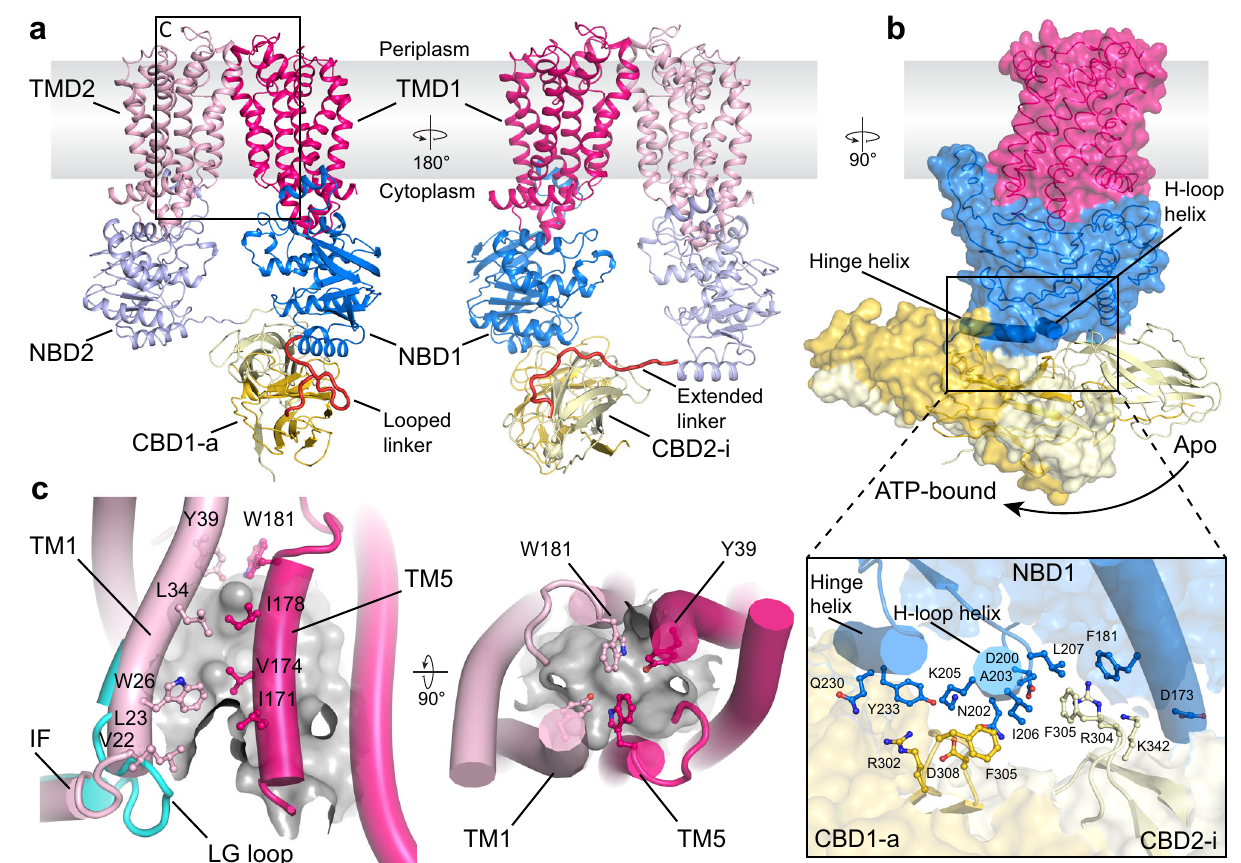
Fig. 3 | Cryo-EM structure of the ADP-bound WzmWzt O antigen transporter. a Overviewof the WzmWzt structure. Loops connecting the NBD with the CBD are colored red. The boxed region is enlarged in panel c . TMD: Transmembrane domain. b CBD position in the transporter ’ s ADP and ATP-bound conformations. The ATP-bound conformation is shown as a semi-transparent surface. The panel